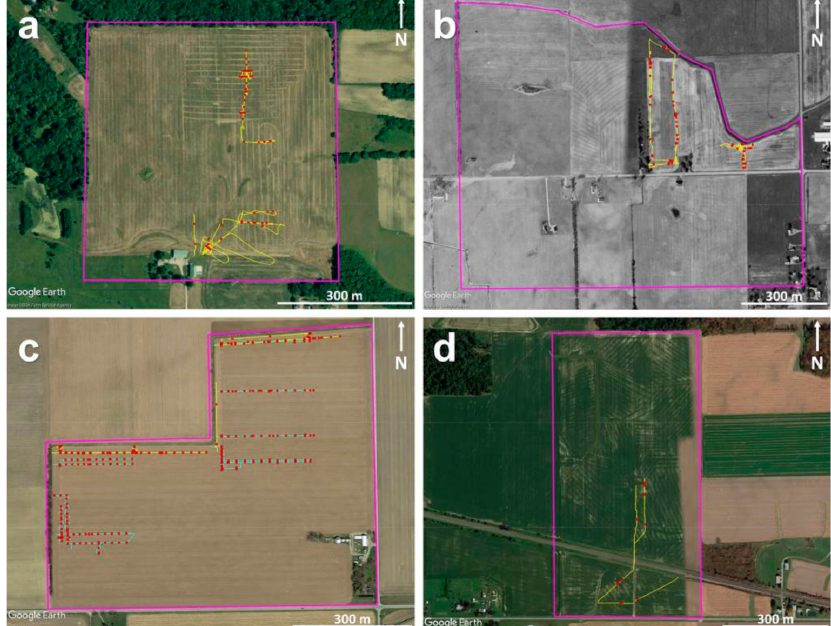
Figure 13. Potential drainage pipe locations marked (with red dots) on the GPR survey transects (yellow and cyan) overlaid on the Google Earth aerial images (same as in Figure 2): ( a ) Site-1, ( b ) Site-2, ( c ) Site-3, and ( d )